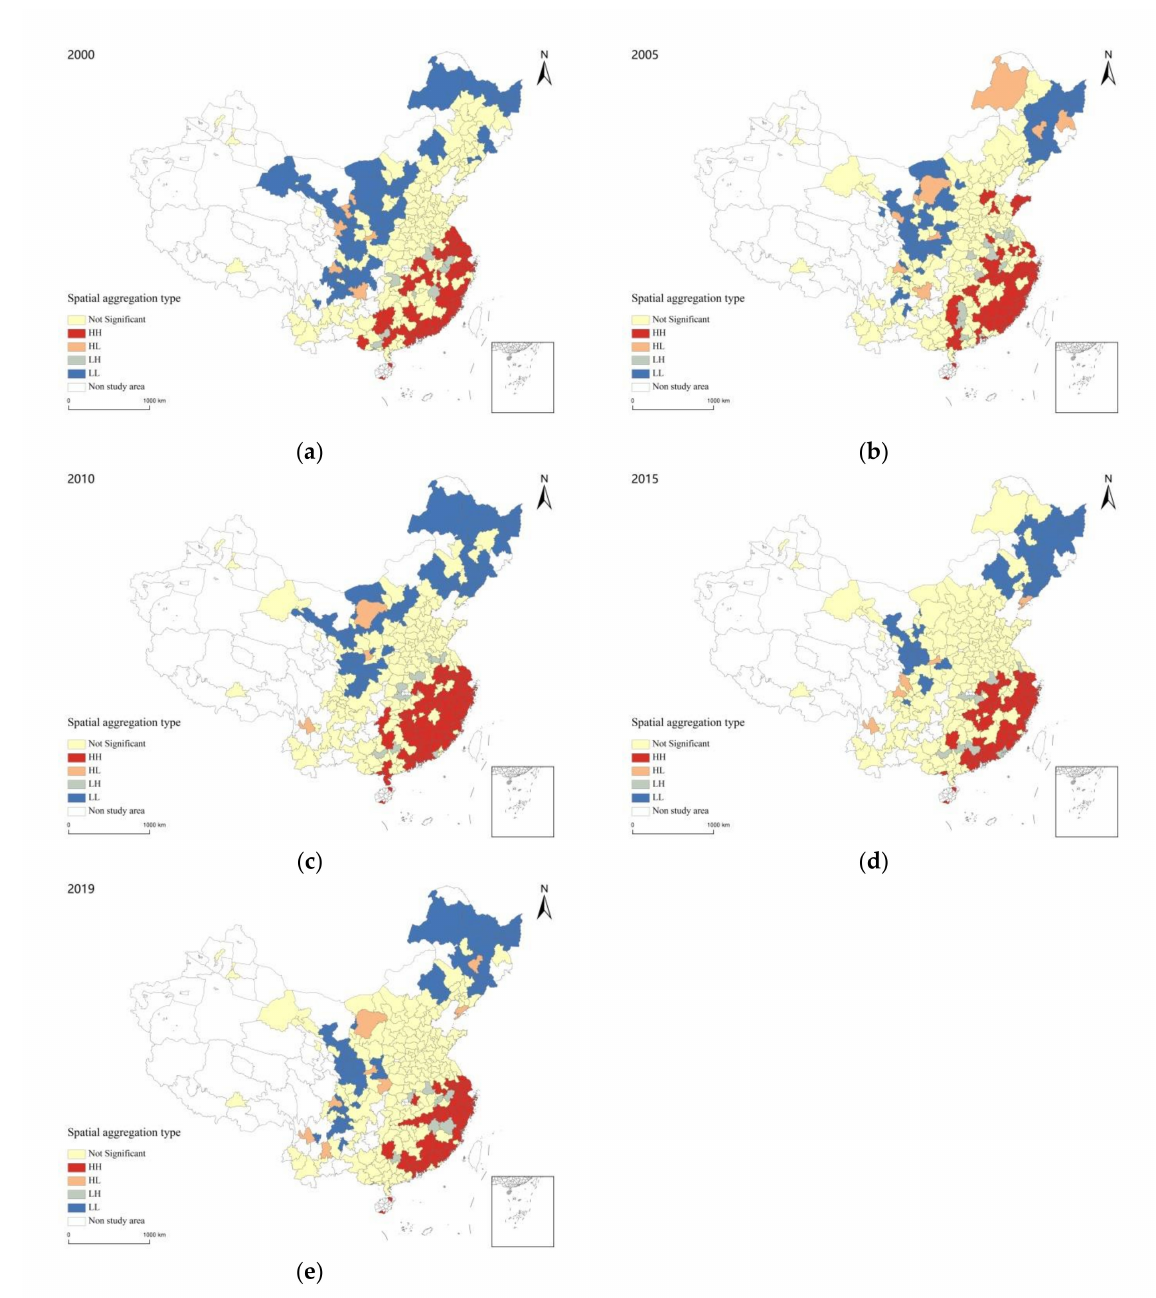
Figure 8. Spatial distribution map of the local indicator of spatial association (LISA) of the sustainable development level of urban human settlements in China. ( a ) 2000; ( b ) 2005; ( c ) 2010; ( d ) 2015; and ( e )